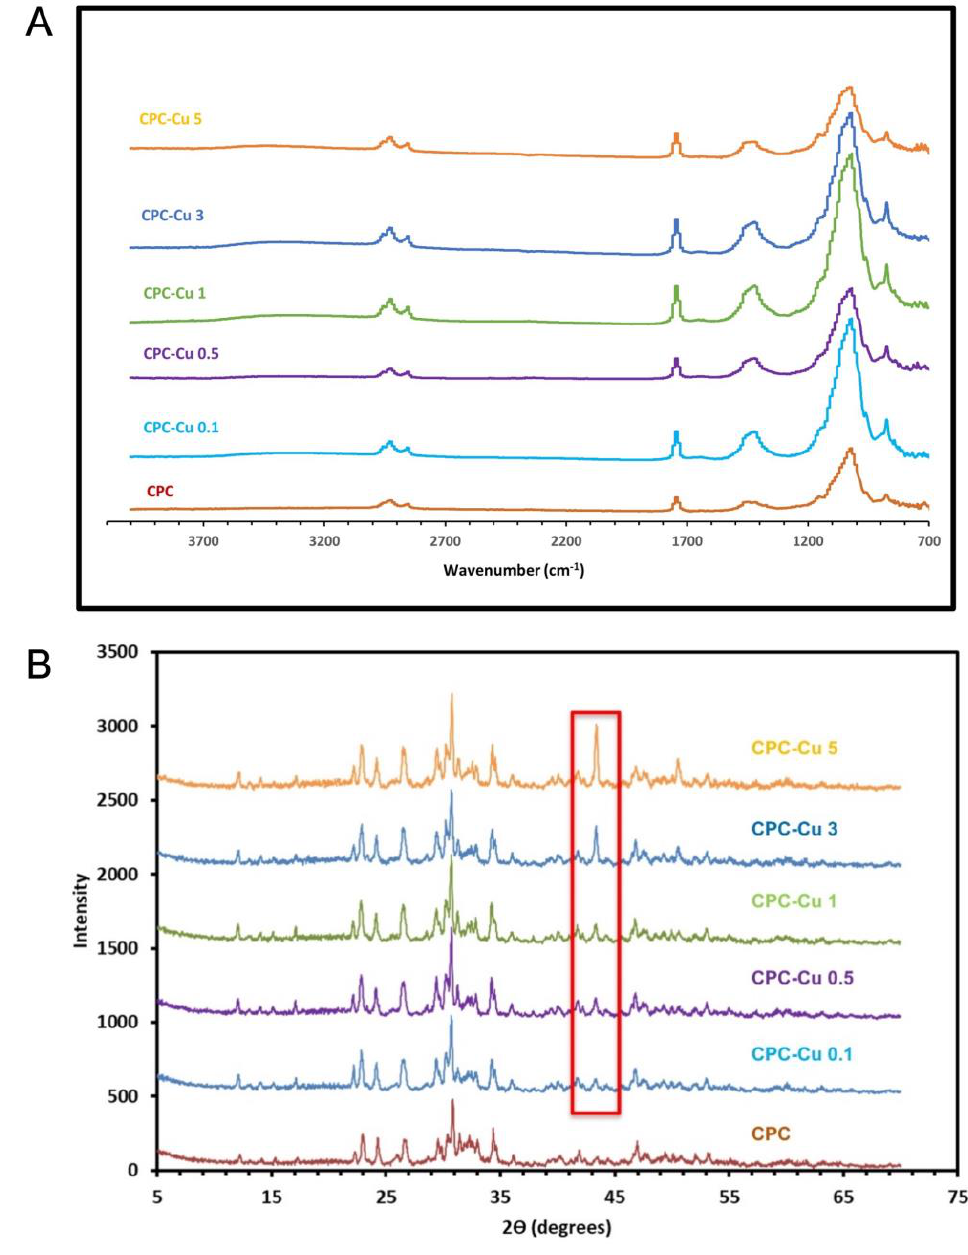
Figure 2. Characterization of scaffolds to understand the surface chemistry with ( A ) FTIR and crystallinity using ( B ) X-ray diffraction spectrum where the part marked in the red box is indicative of the copper